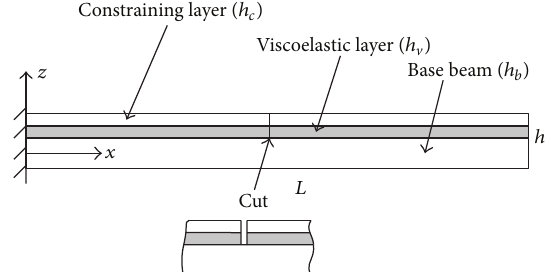
Figure 1: Cantilever beam with segmented CLD treatments.